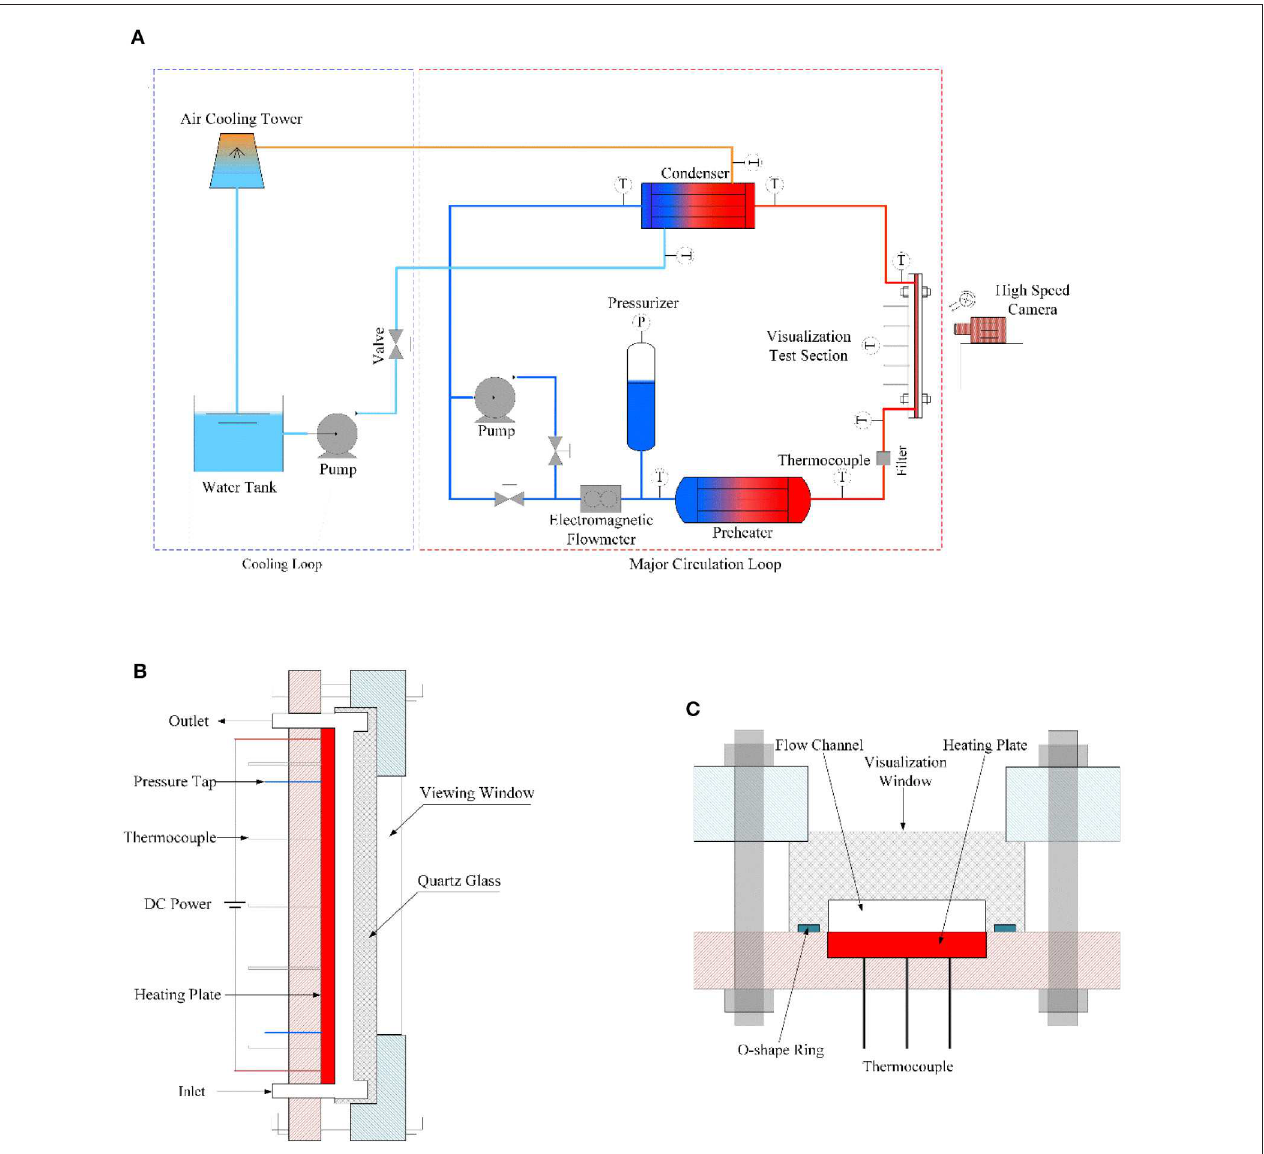
FIGURE 1 | Schematic diagram of experimental equipment. (A) Schematic diagram of the experimental loop, (B) side section of the visualization test section, and (C) cross section of the visualization test